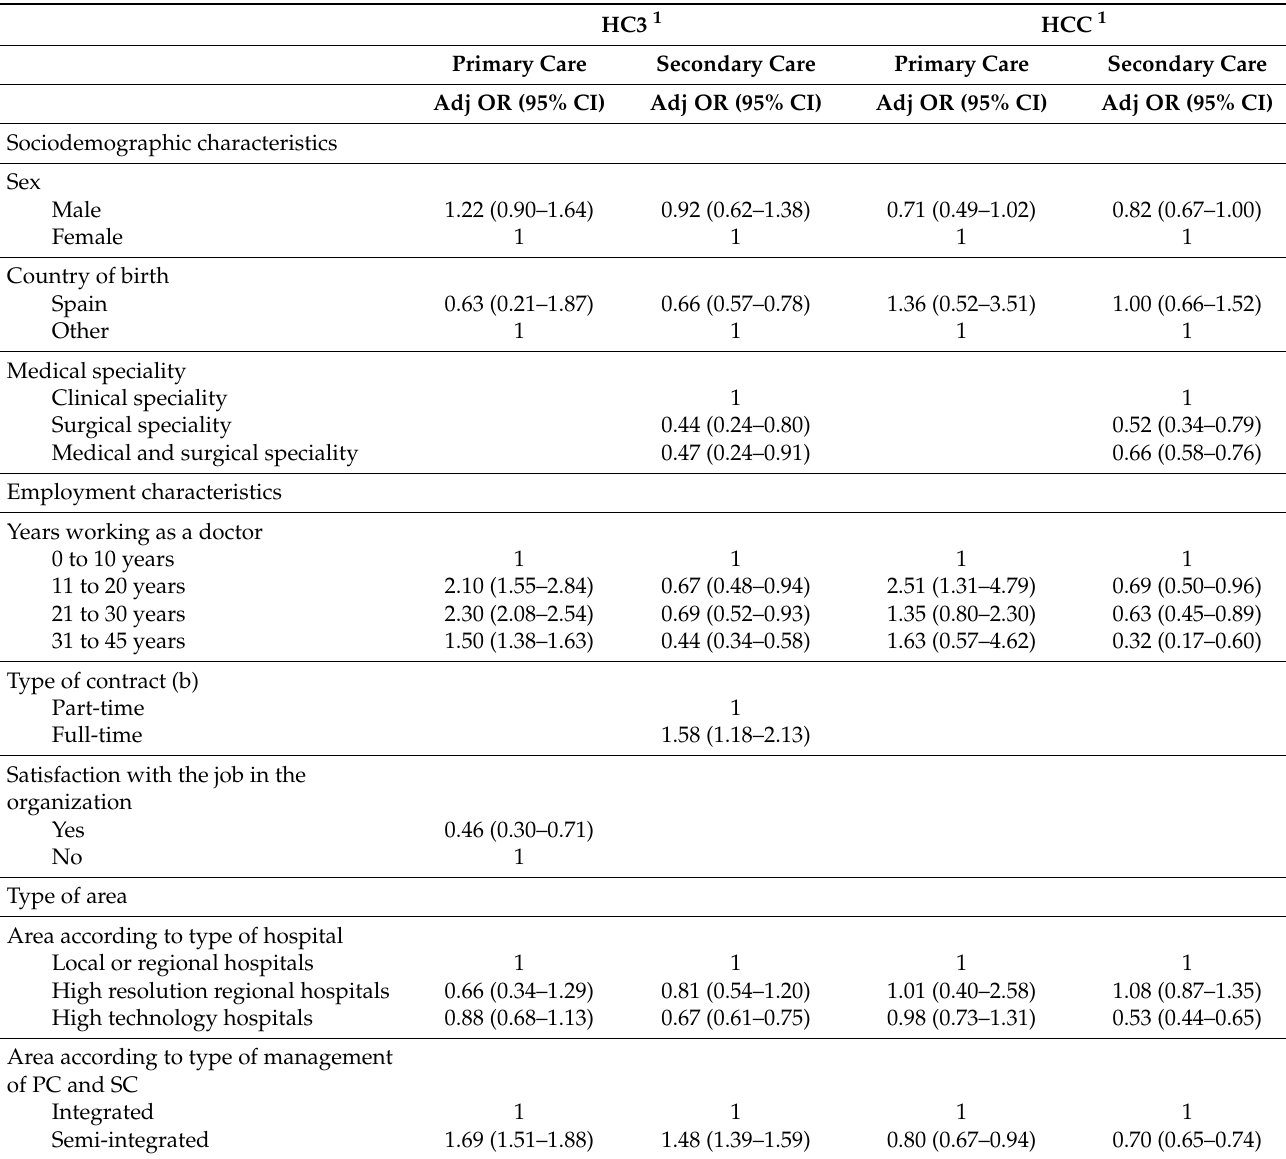
Table 3. Factors associated with frequent use of the shared Electronic Medical Records (EMRs), by level of